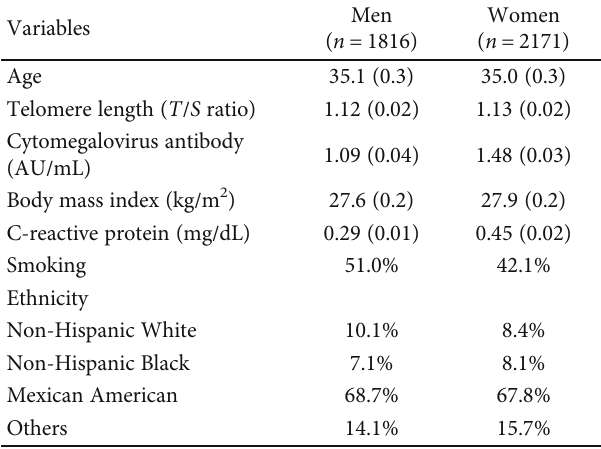
Table 1: Basic characteristics of study participants in NHANES.